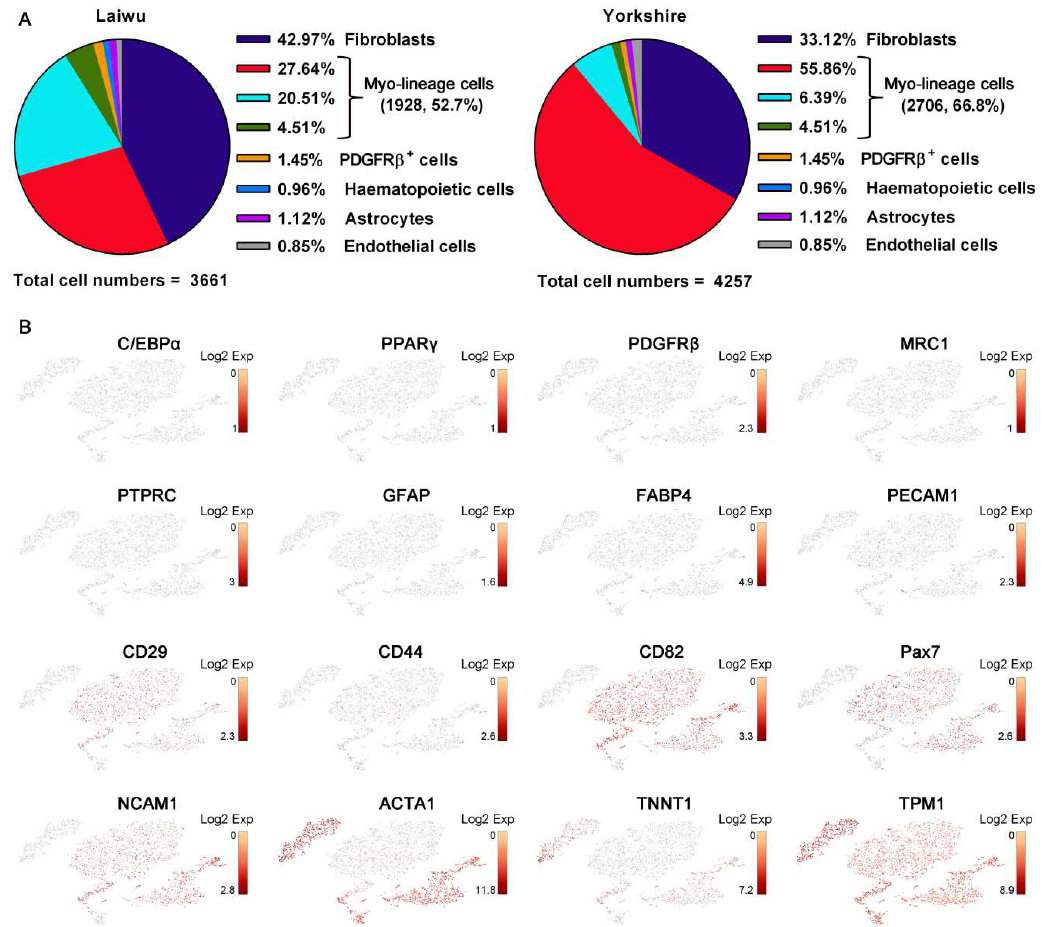
Figure 3. Skeletal muscle cells classified by single-cell RNA sequencing. ( A ) The clusters of muscle- derived cells of obese- or lean-type pigs. ( B ) Individual gene t-distributed stochastic neighbor embedding (tSNE) plots showing the expression levels of cell-type selective markers among Myo-lineage cells.